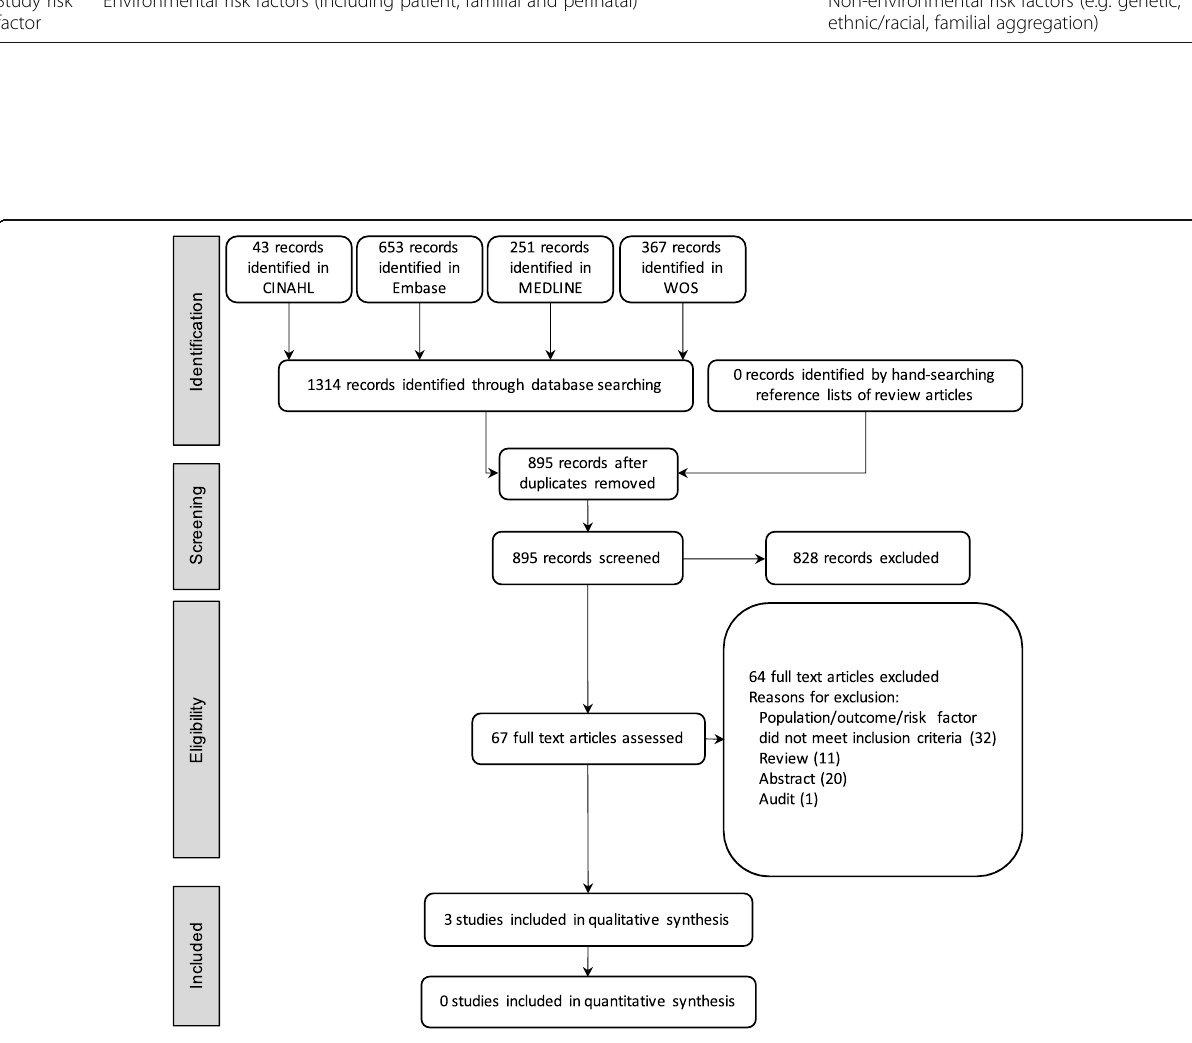
Fig. 1 PRISMA flow diagram of study